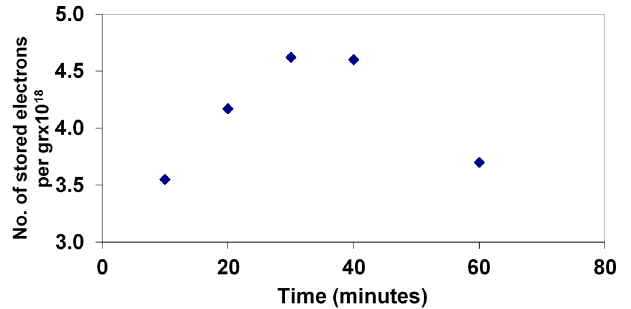
Figure 5. Stored electron levels during the photocatalytic degradation of 4-CP measured by Fe(III) titration with Fe(II) detection by phenanthroline complexation.